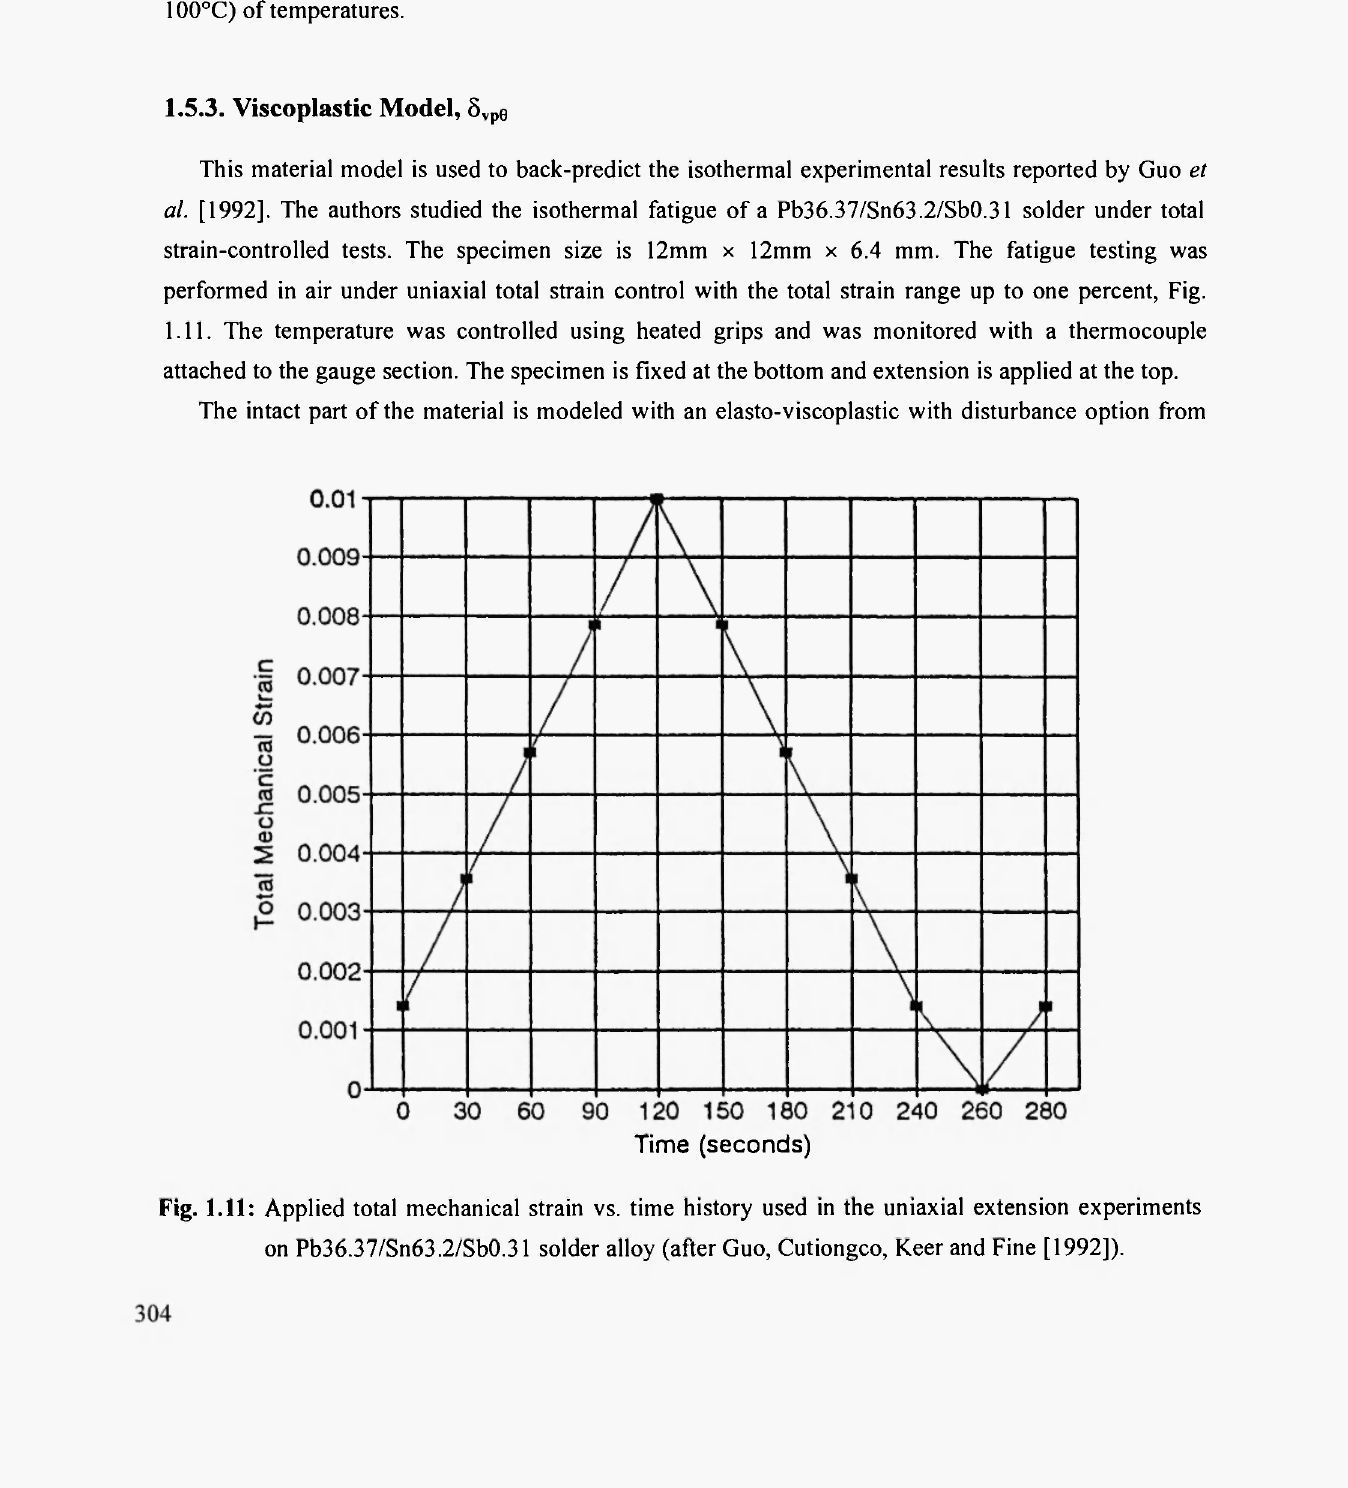
Fig. 1.11: Applied total mechanical strain vs. time history used in the uniaxial extension experiments on Pb36.37/Sn63.2/Sb0.31 solder alloy (after Guo, Cutiongco, Keer and Fine